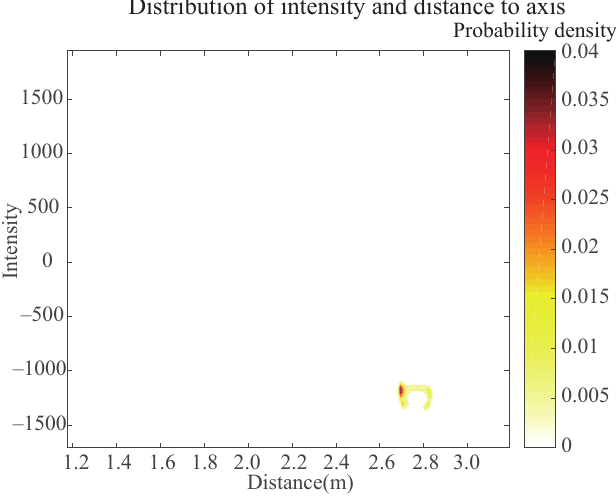
Figure 12. Two-dimensional probability distribution of distances and intensities.